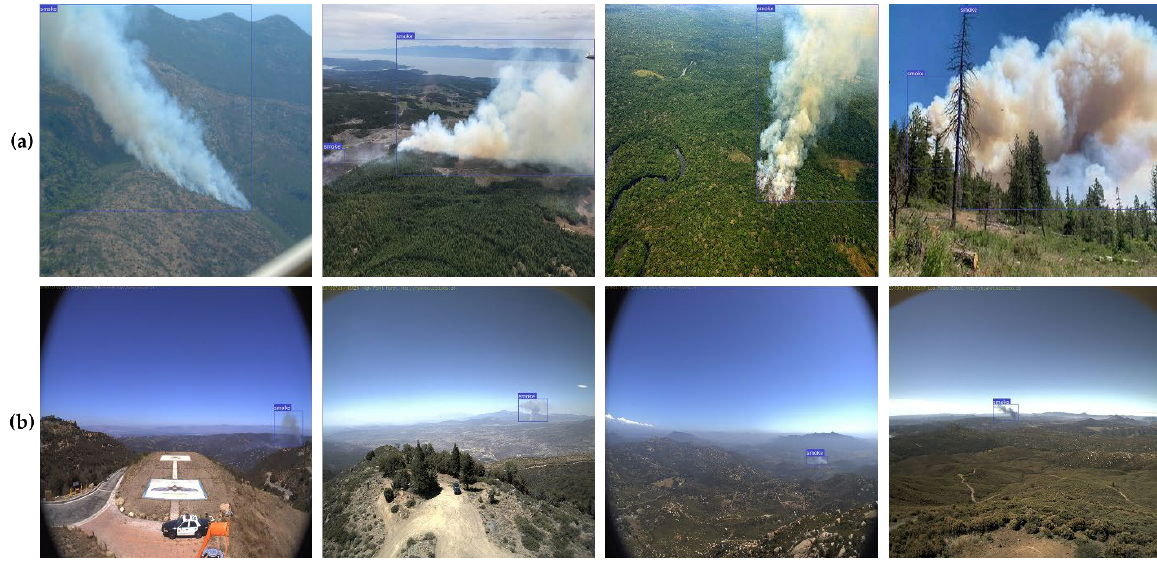
Figure 10. Results of the proposed wildfire smoke detection system for different forest environments: ( a ) large-sized smoke images, ( b ) small-sized smoke